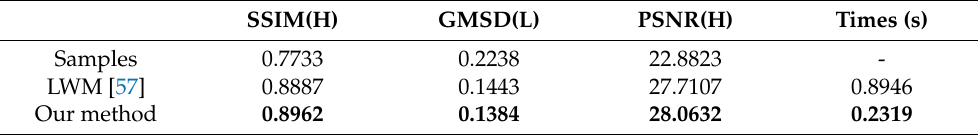
Table 3. Comparison results of robustness of LWM method and our method.